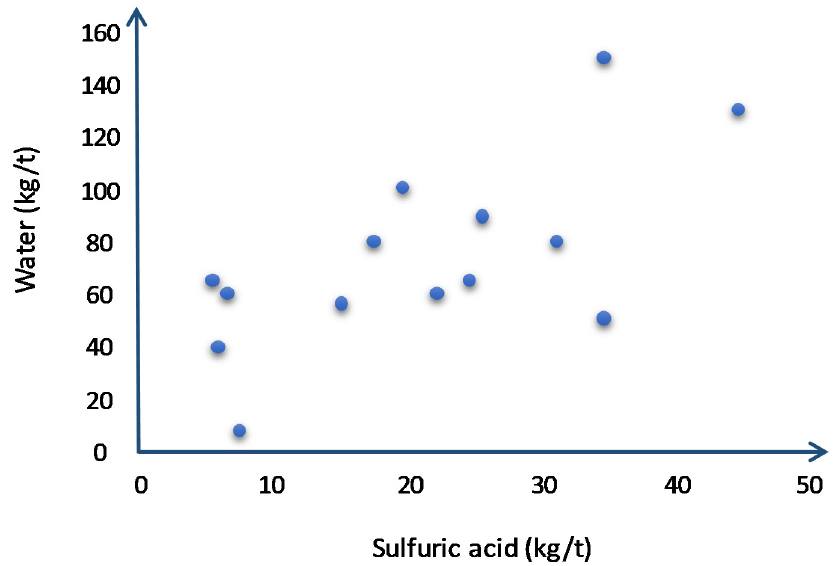
Figure 7. Study of sulfuric acid and water additions from 14 copper heap leaching operations (Modified from [50]).